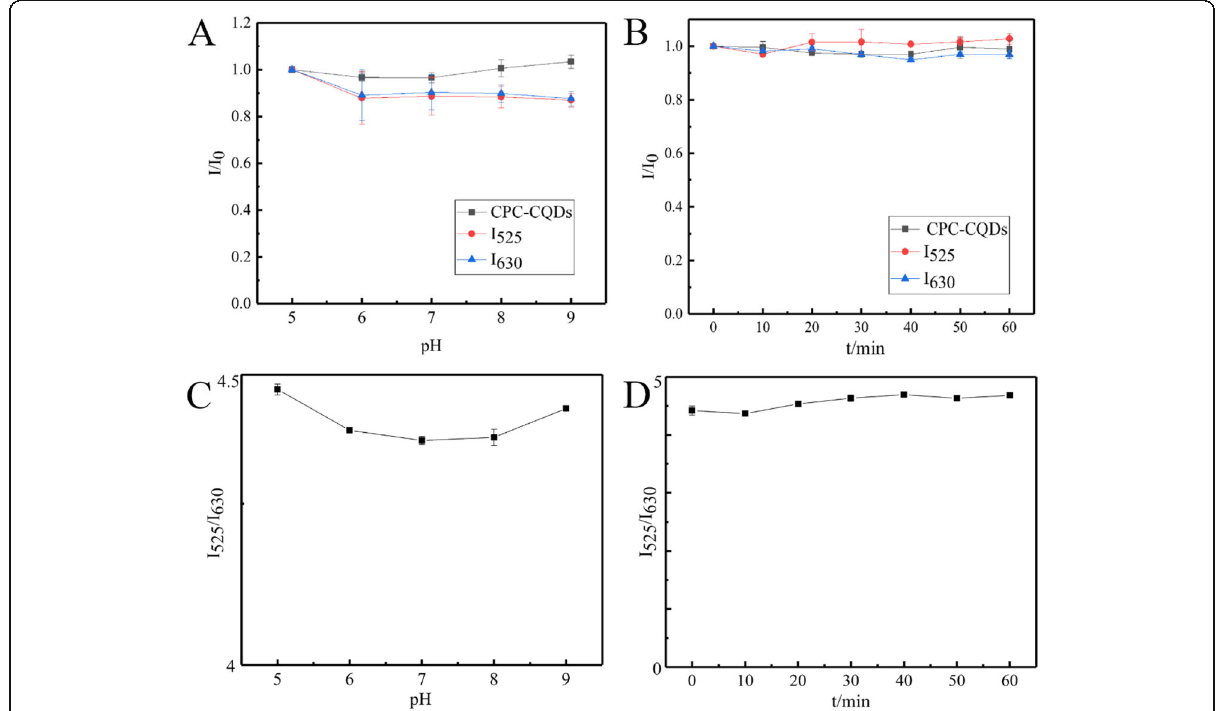
Fig. 5 The pH stability ( a , c ) and photostability under continuous UV irradiation ( b , d ) of CPC-CQDs and the fluorescent